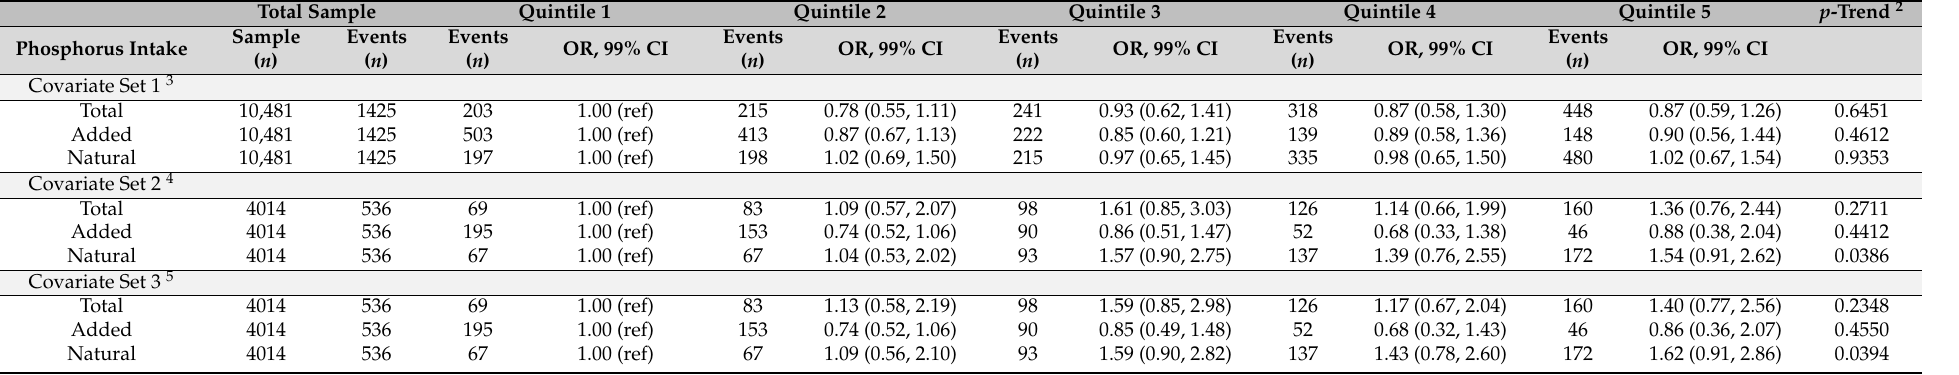
Table 5. Dietary phosphorus intake density 1 (mg/kcal) association with mortality by quintile of intake (g). Total Sample Quintile 1 Quintile 2 Quintile 3 Quintile 4 Quintile 5 p -Trend